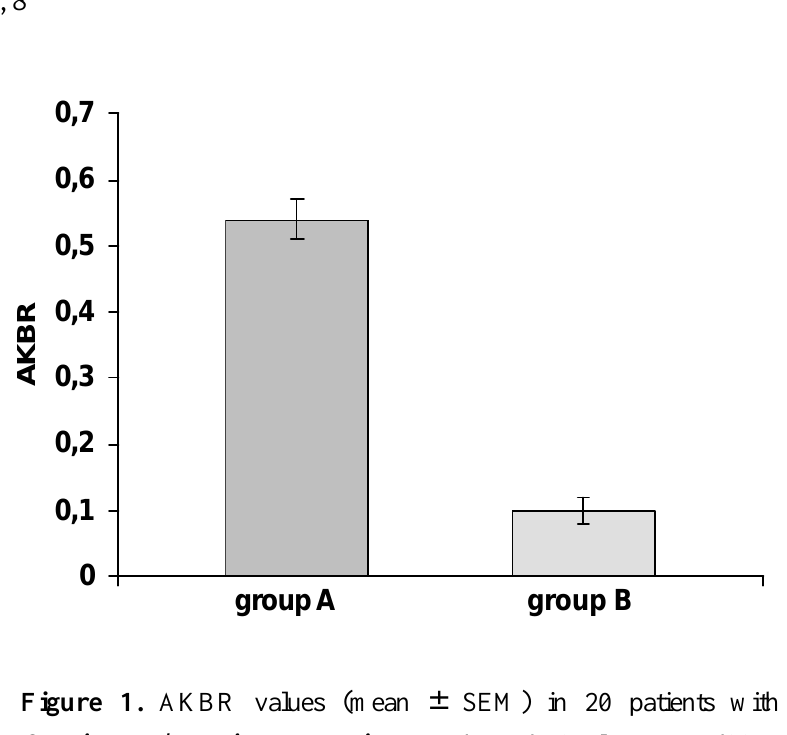
Figure 1. AKBR values (mean – SEM) in 20 patients with Carcinoma hepatis metastaticum and good circulatory condition (group A) and 16 patients with Carcinoma hepatis metastaticum and chronic cardiogenic circulatory insufficiency (group B).